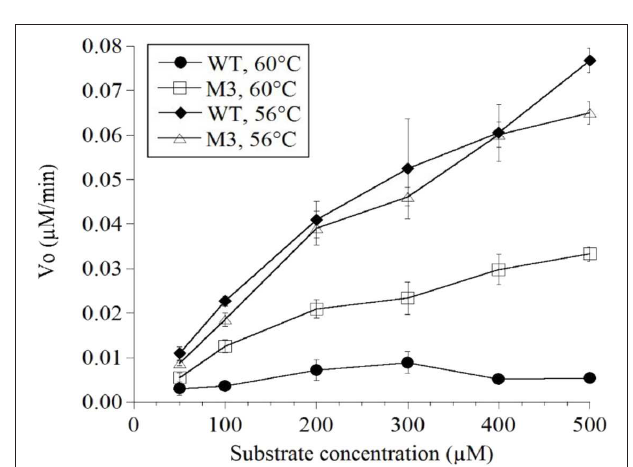
FIGURE 3 | Determination of the thermostability of wild type (WT) control and EP-B2 variant dubbed M3 (K180A) using a synthetic substrate, Z-Phe-Arg-pNA. Enzyme activity was measured at 56 and 60 ◦ C, and was compared with the wild type control. To monitor enzyme activity absorbance was recorded at 410nm. The Beer-Lambert equation (A = ε c l) and the concentration of the product was calculated based on the extinction coefficient for pNa (8.8mM). Concentration is expressed as µ